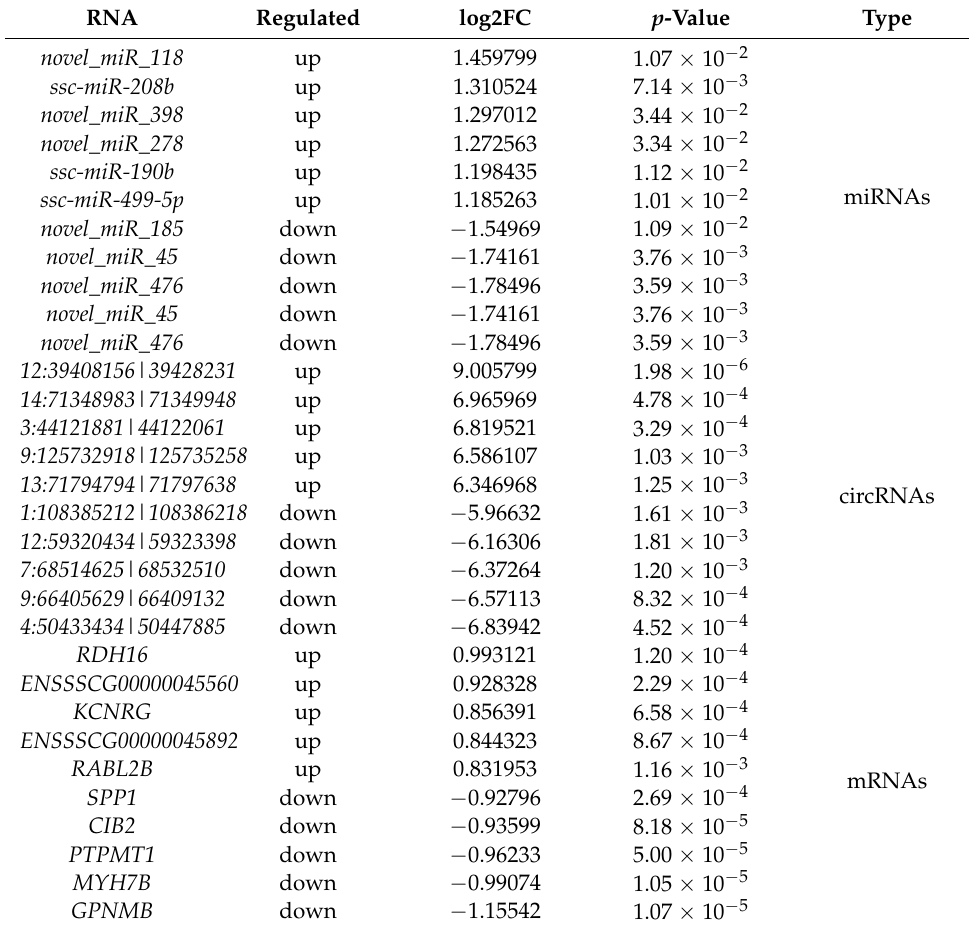
Table 2. Cont. RNA